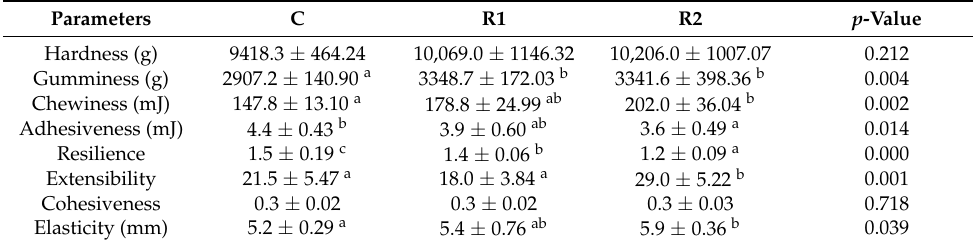
Table 3. Instrumental texture of fuet sausages (means ±